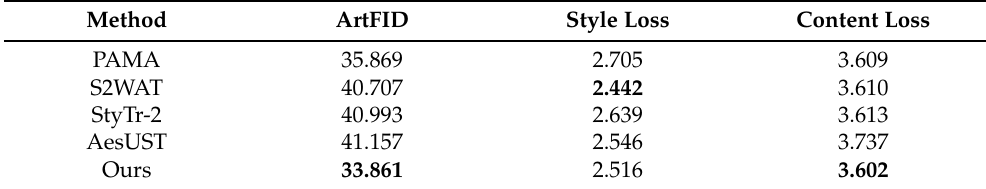
Table 2. Objective evaluation of